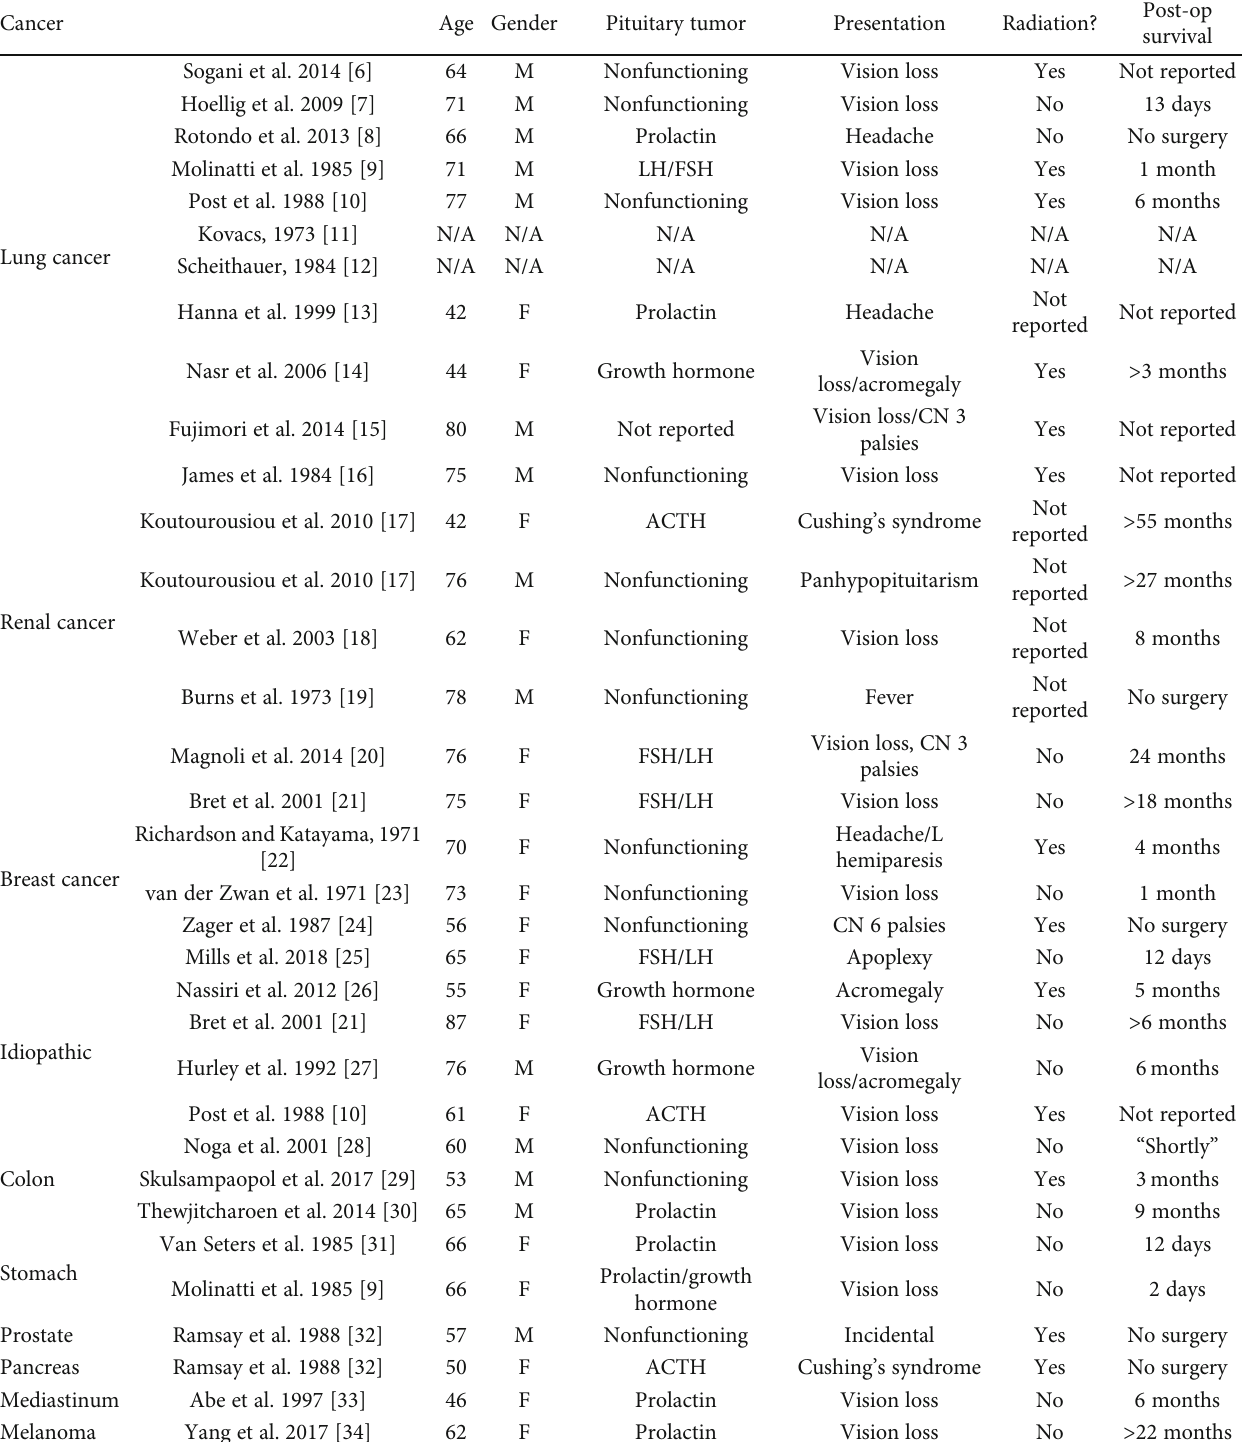
Table 1: Literature review of clinical cases involving metastasis of systemic malignancy into a pituitary adenoma. Cancer Age Gender Pituitary tumor Presentation Radiation?